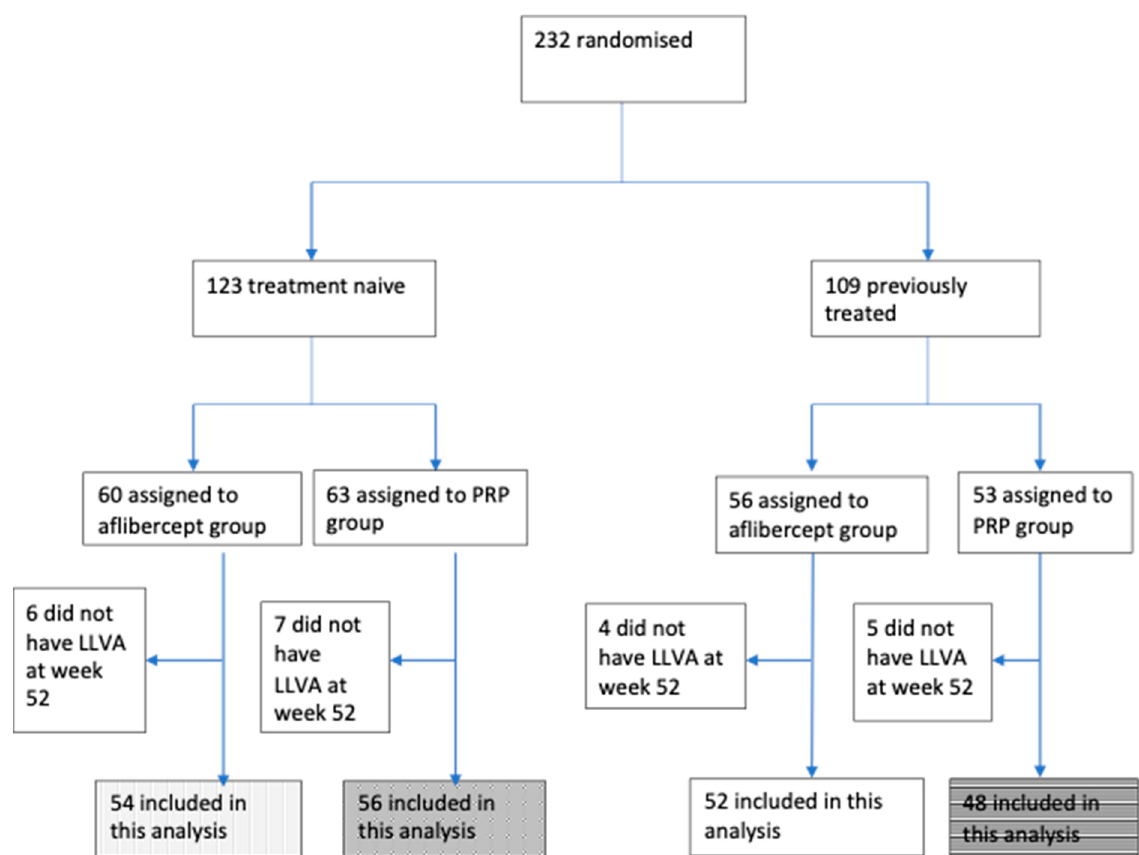
Figure 1. Flow chart of participants in this study. PRP: pan-retinal photocoagulation. LLVA: low luminance visual acuity.